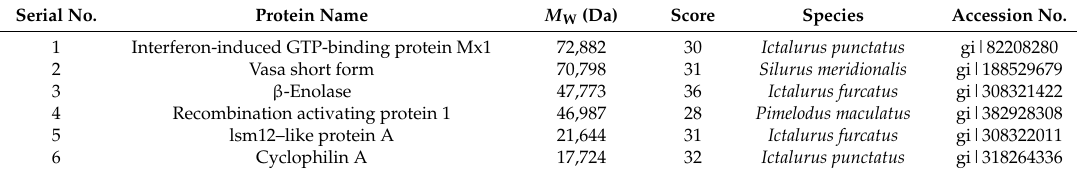
Table 1. Proteins putatively annotated in the skin mucus of yellow catfish using mass spectrometry. The detailed procedure used to putatively annotate the detected protein is present in the Materials and Methods section. Mucus was assessed by mass spectrometry; the identified proteins are shown with their molecular masses and the matching species with the accession number in the database.